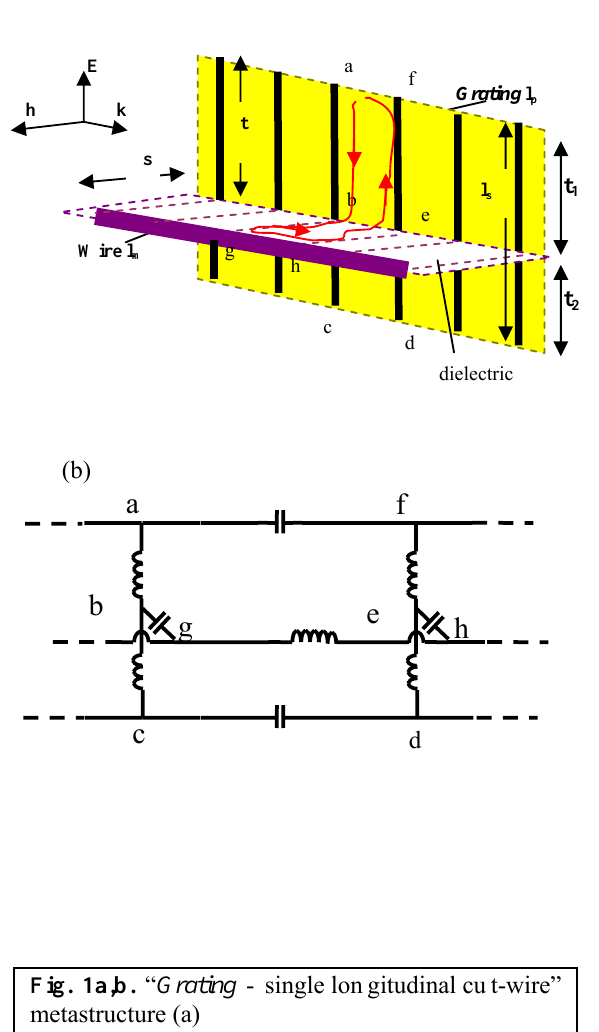
Fig. 1a,b. “ Grating - single lon gitudinal cu t-wire” metastructure (a) and its equivalent electric diagram